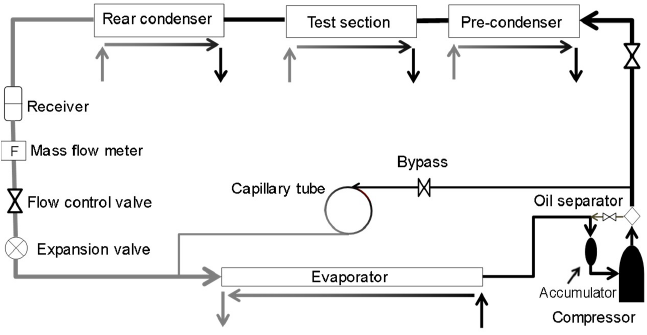
Figure 1. Schematic of the experimental setup.